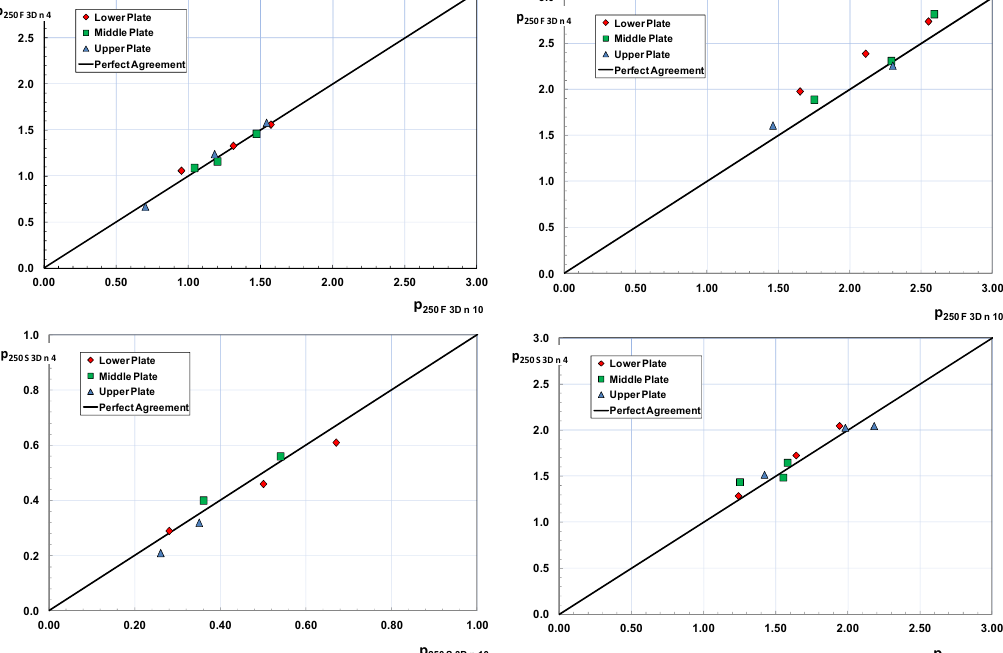
= 0.125 m, T = 1.55 s; right: H = 0.208 m, T = 1.94. Low s p s p = 0.042 m, T = 1.03 s; right: H = 0.167 m, T = 1.81 s p s p